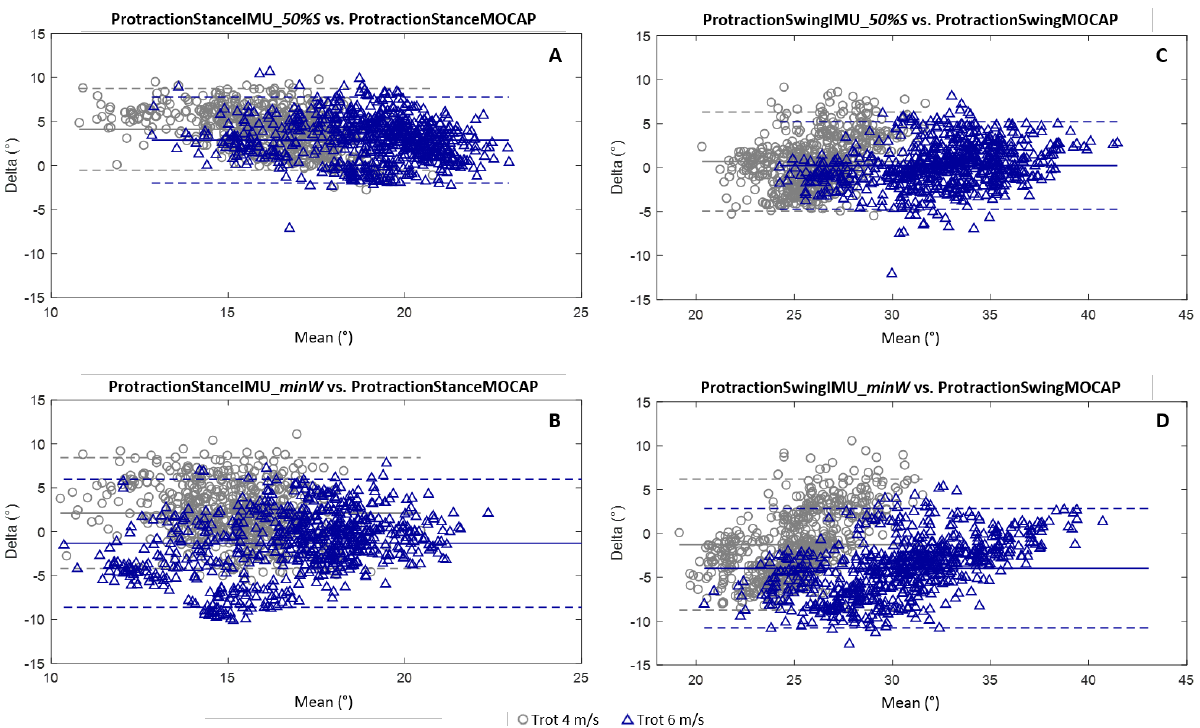
Figure 7. Bland–Altman graphs for the comparison of the protraction angles at a stance obtained using the indices 50%Stance ( A ) and minWithers ( B ) and of the angles of maximal protraction obtained using the indices 50%Stance ( C ) and minWithers ( D ) with the protraction angles, respectively, at a stance and at a swing obtained from the MOCAP data. The results for the 4 m/s trot are shown in gray (o) and the results for the 6 m/s trot are shown in blue (Δ). The accuracy (bias between the developed method and the MOCAP) and the limits of the confidence interval (95% of values) are shown for each graph.